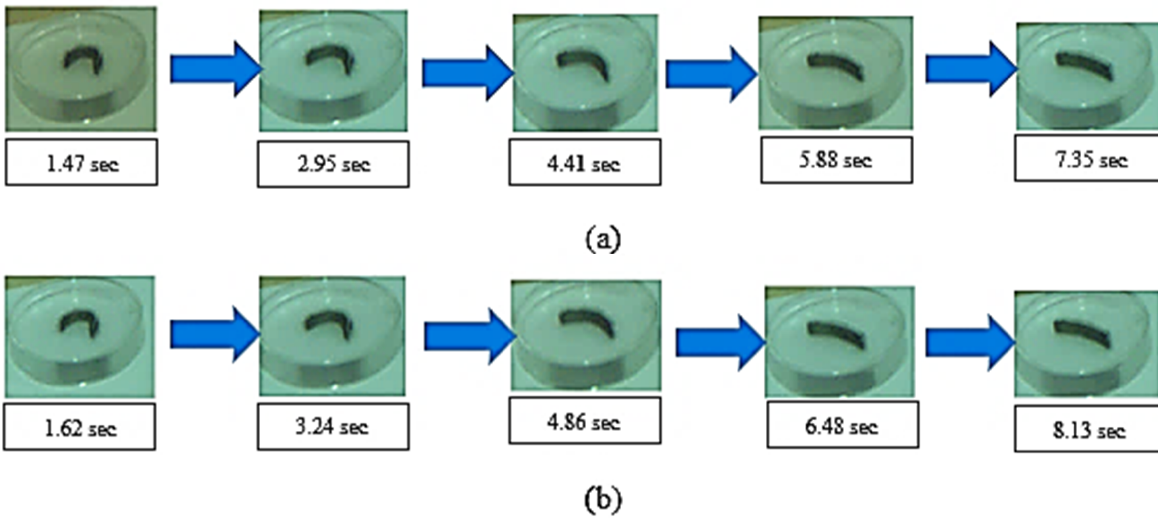
Figure 16. Strain Recovery testing with recovery time and temperature of a sample printed with optimal condition ( a ) Under 0.1% addition of Graphene ( b ) Under 0.3% addition of Graphene.